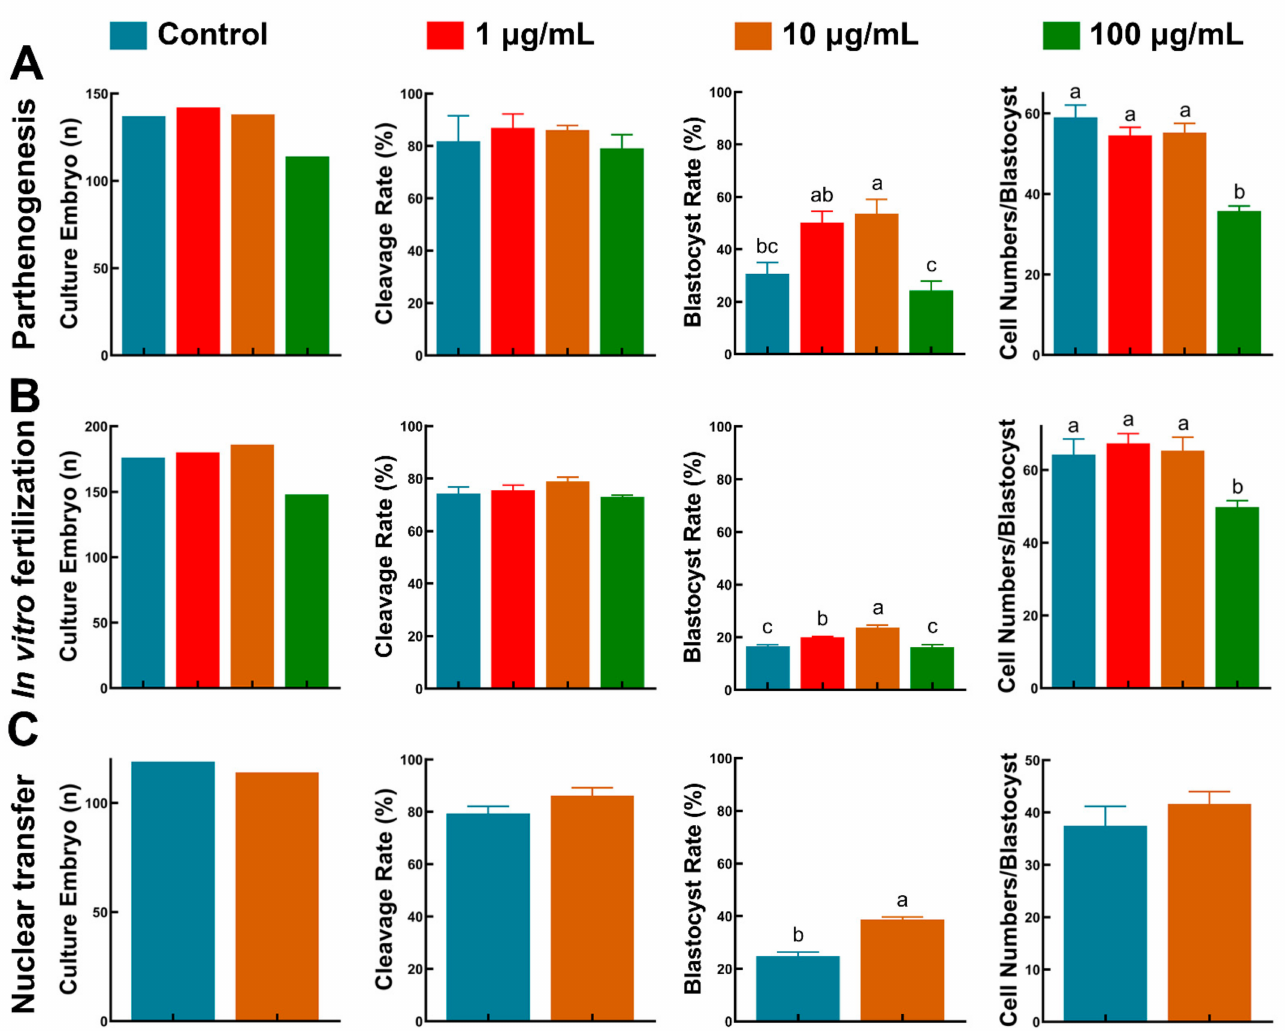
Figure 7. The effect of TA supplementation during in vitro maturation on embryonic development after ( A ) parthenogenesis, ( B ) in vitro fertilization and ( C ) somatic cell nuclear transfer. Bars with different letters denote significant differences ( p < 0.05). Results are shown as the average ± SEM of at least three repeats of independent